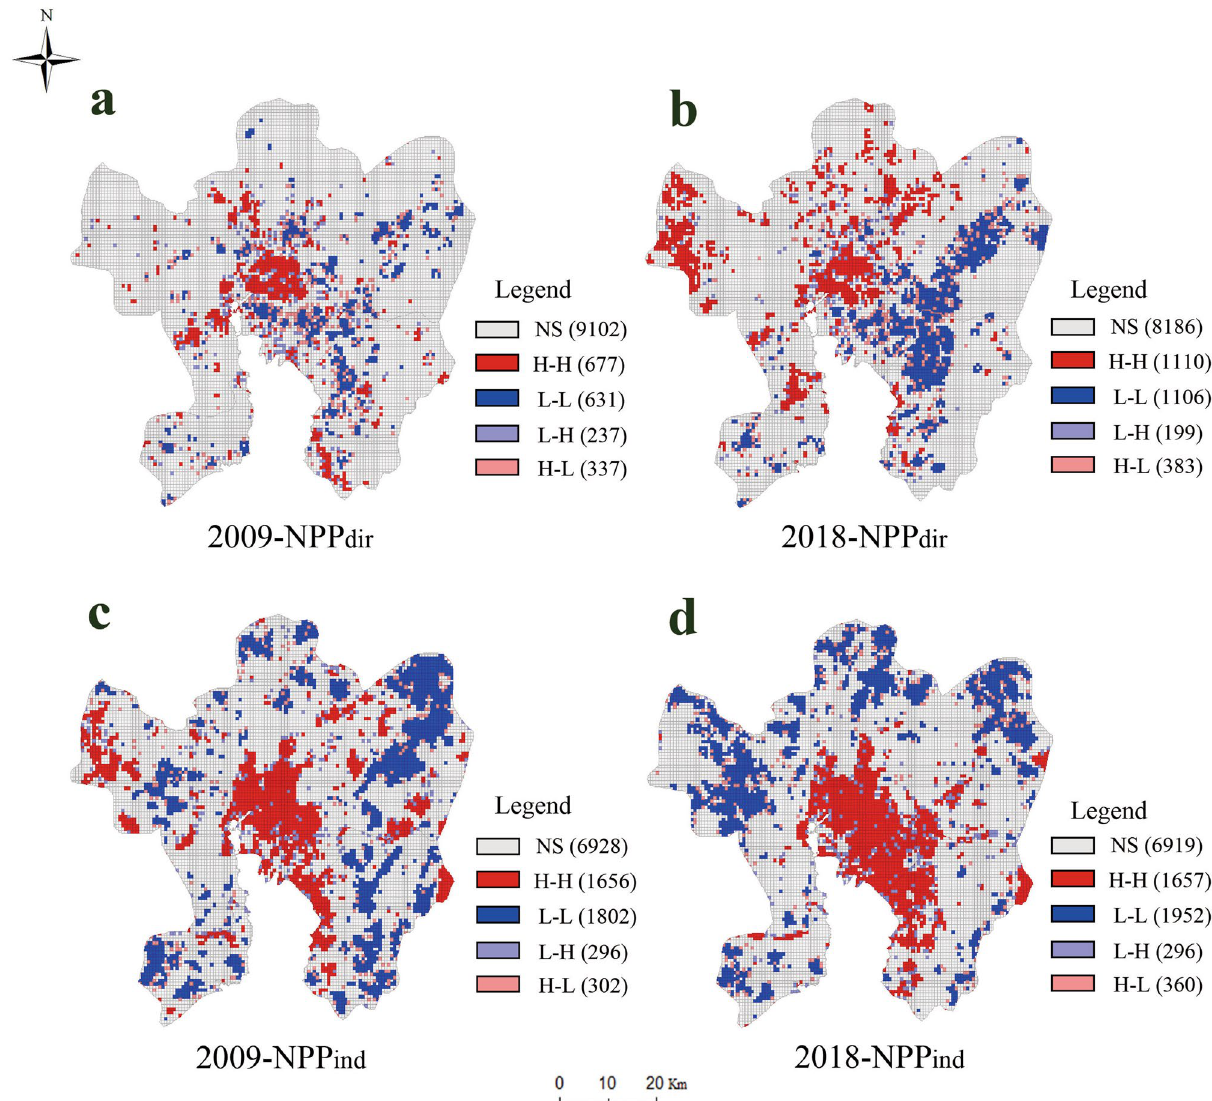
Figure 2. LISA cluster maps of NPP dir ( a , b ) and NPP ind ( c , d ) in 2009 and 2018. NPP dir is the direct impact of urbanization on NPP and NPP ind is the indirect impact of NPP.